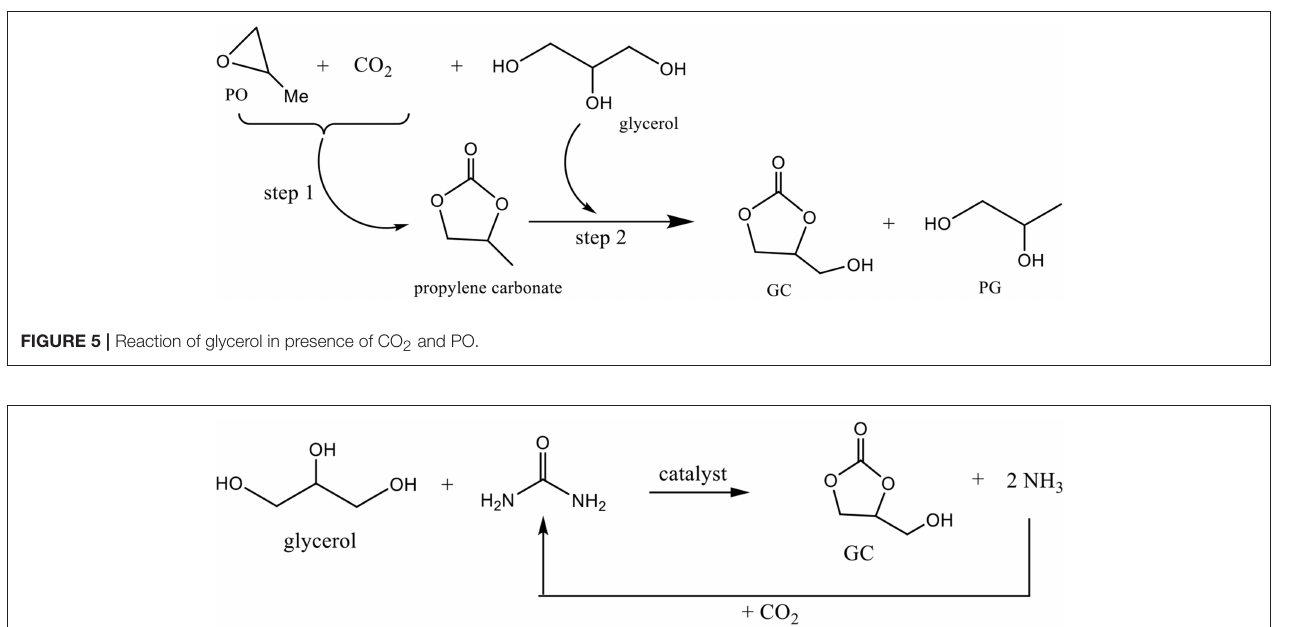
group of glycerol and the basic sites favor the CO 2 absorption and